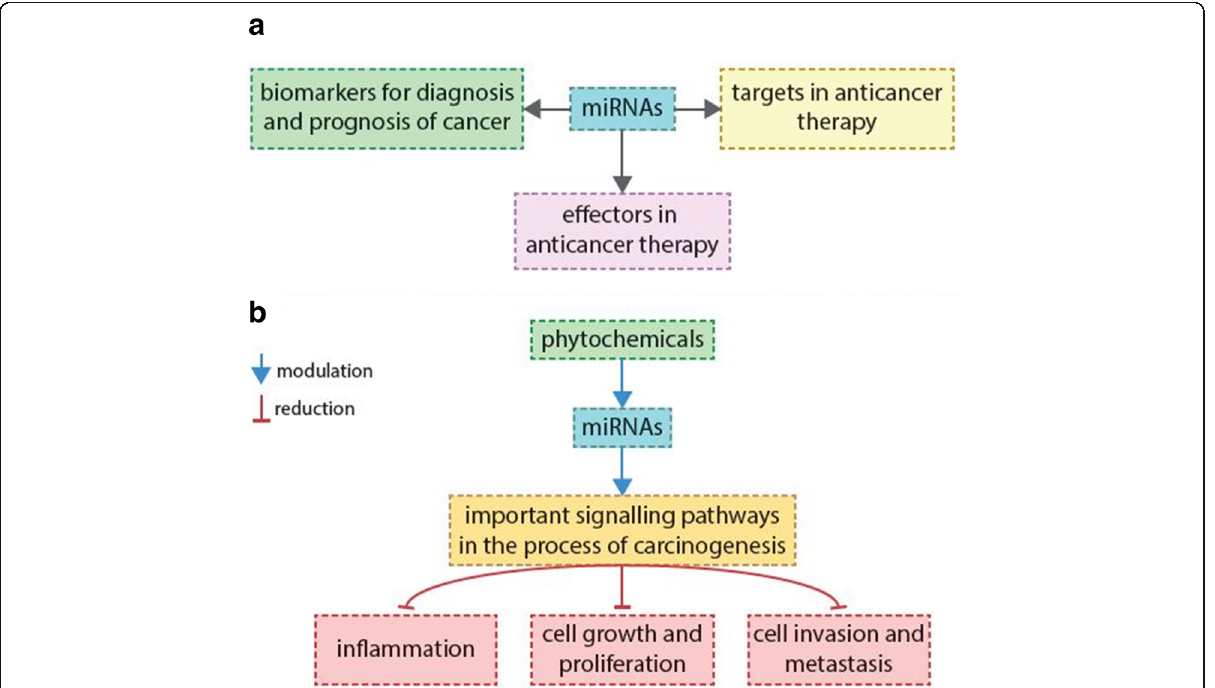
Fig. 5 Importance of miRNAs and phytochemicals involved in the process of carcinogenesis. For more details, see the text –– the section “ Modulation of non-coding RNAs